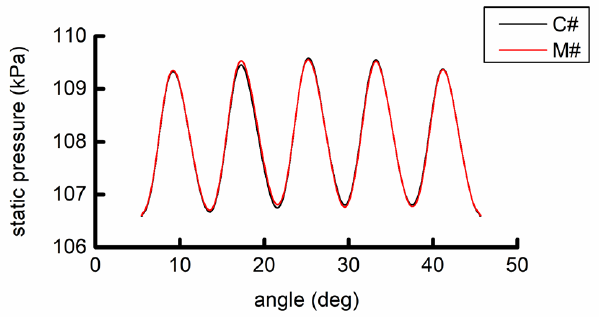
Figure 26. Time-averaged static pressure at 50% blade span at R1/S1 interface.